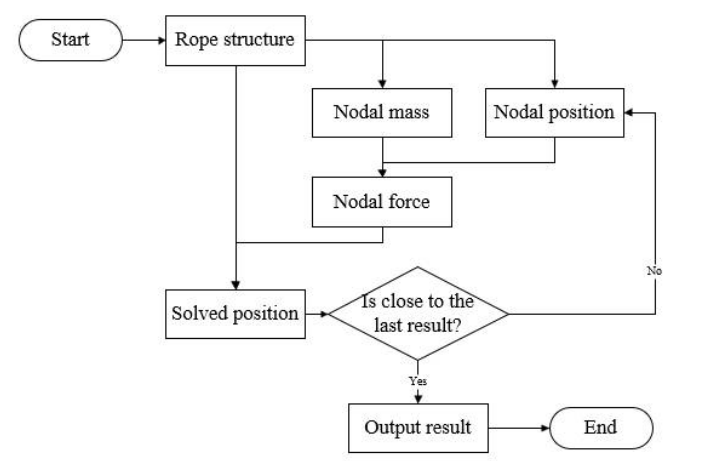
Figure 5. Logic diagram of FEM calculation.